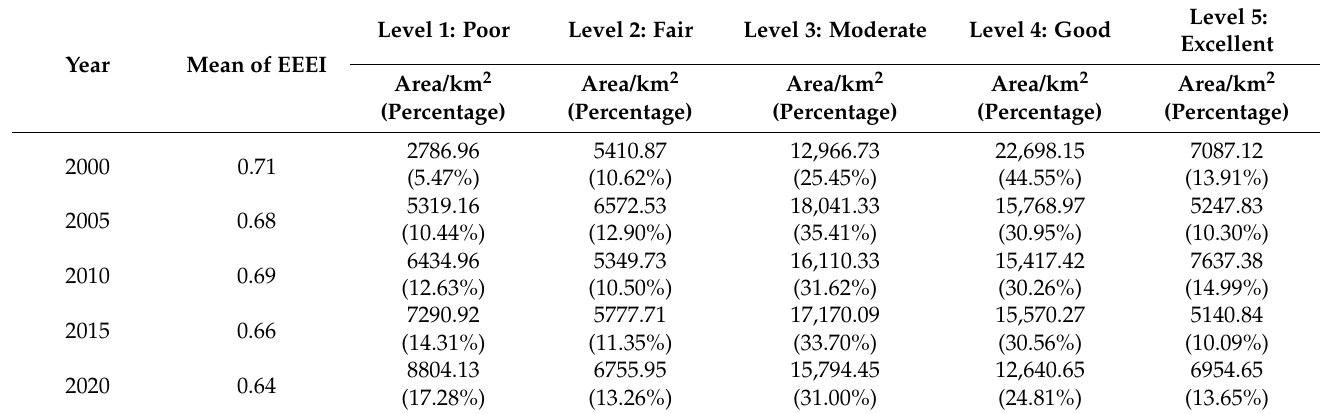
Table 6. Statistics of ecological quality of the GBA from 2000 to